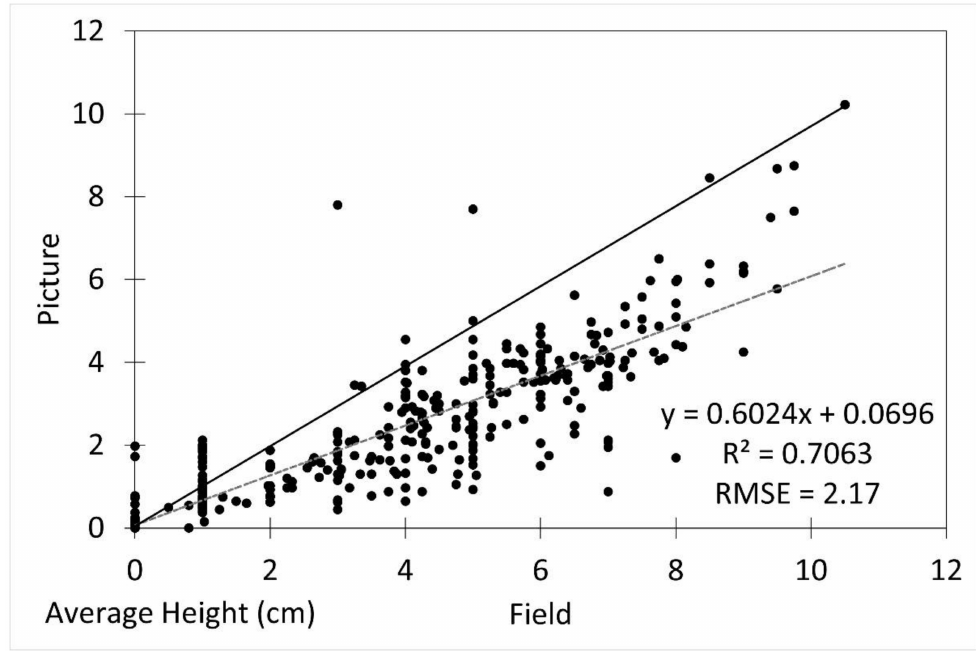
Figure 3. Scatterplot of field vs. picture average seedling height with fitted linear regression line (dotted line) and 1:1 line (solid line). R 2 was 0.7063 and RMSE was